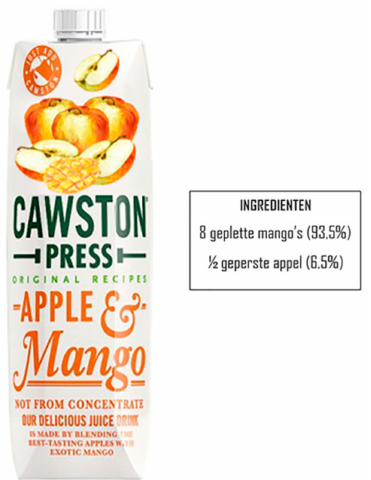
Figure 2. Example of the condition pictorializing more apples incongruent with the ingredient